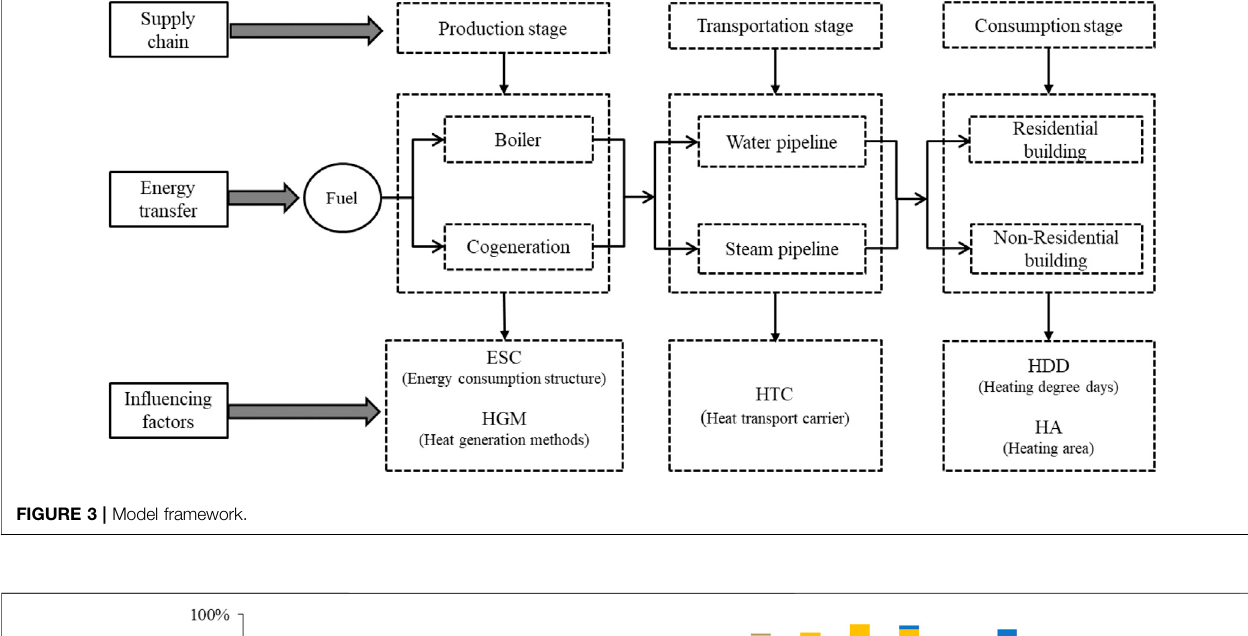
FIGURE 3 | Model framework.